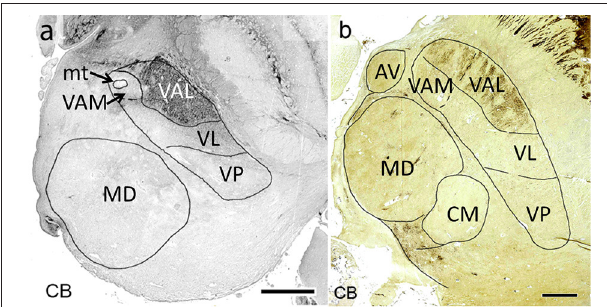
FIGURE 7 | Horizontal calbindin-stained sections through the middle of the mediodorsal nucleus at 19 weeks of gestation (a) and at adulthood (b) . Within the lateral nuclei calbindin-immunoreactivity is observed exclusively in the pallidal territory (VAL).